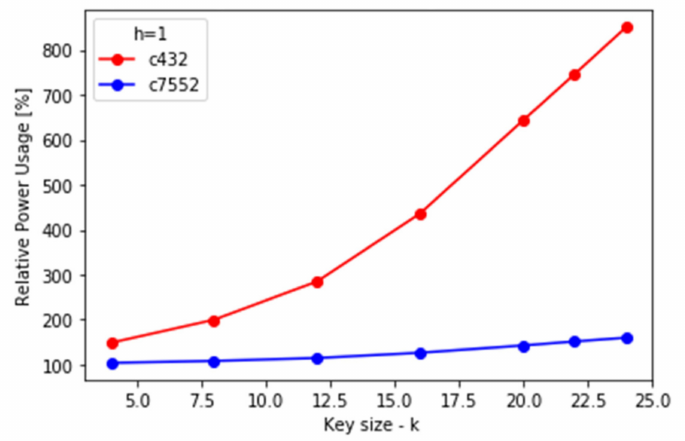
Figure 25. Relative power usage increase in locked netlists for different values of key size.